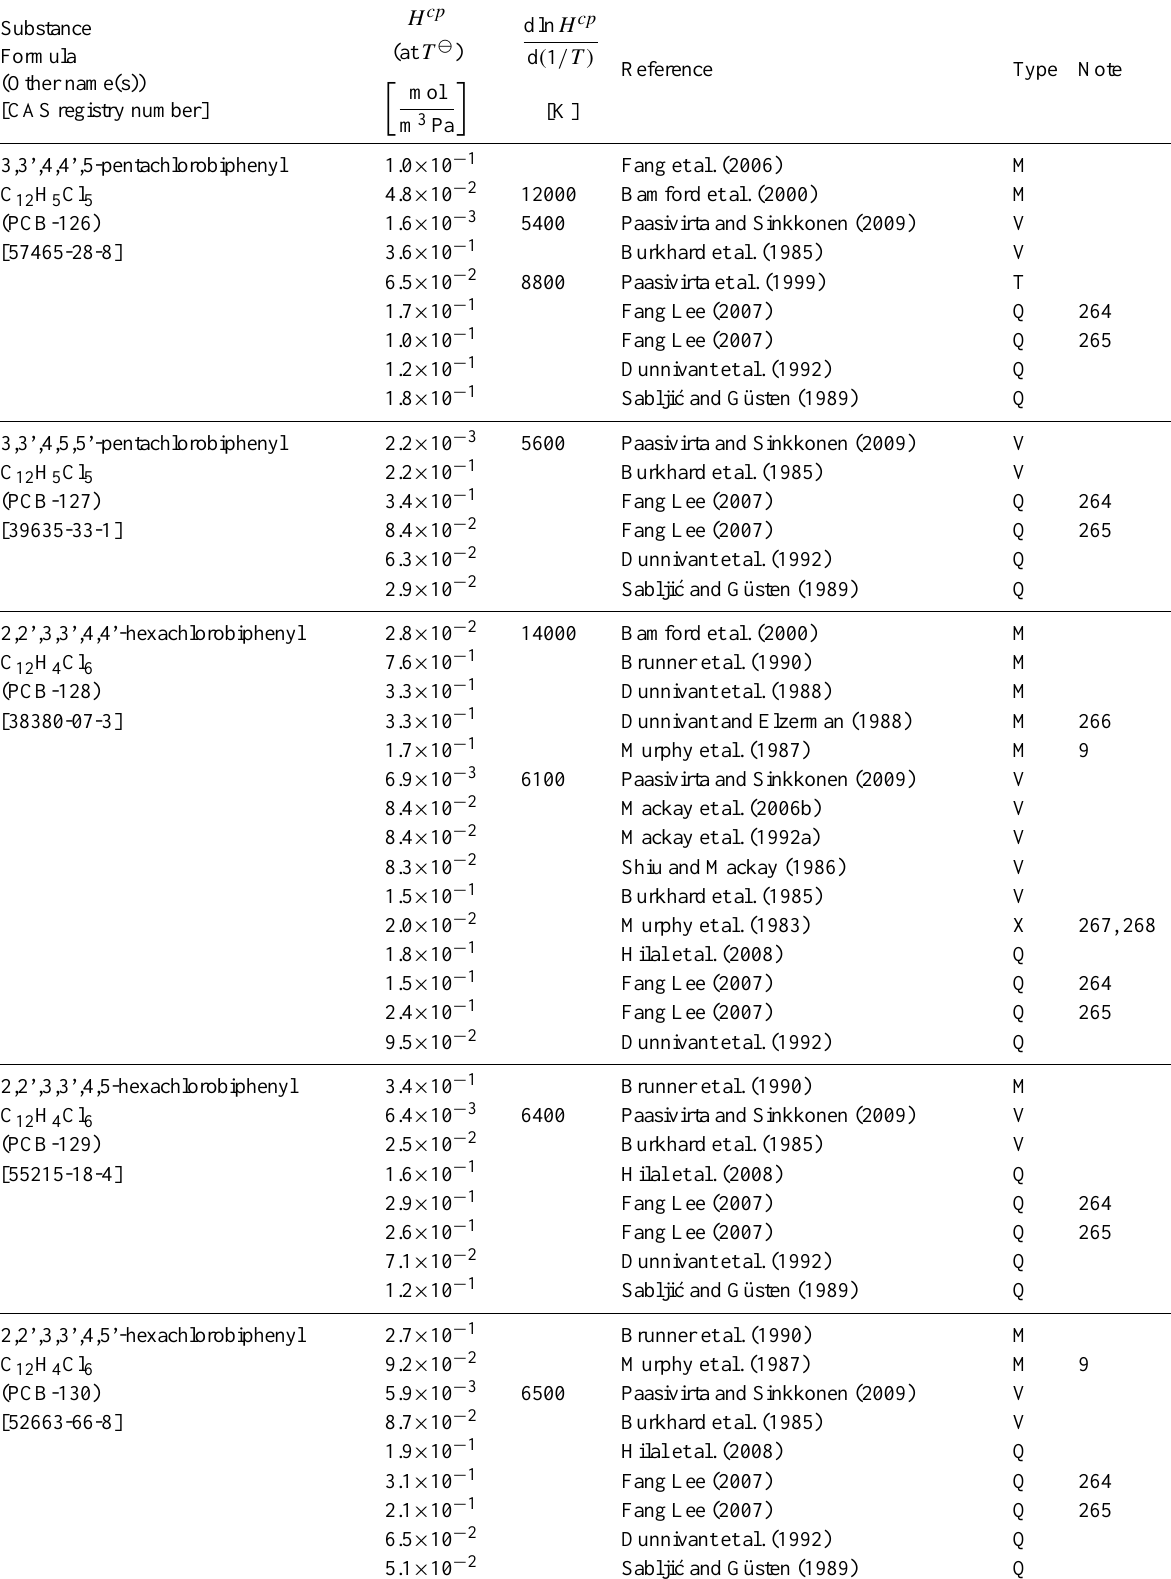
Table 6: Henry’s law constants for water as solvent